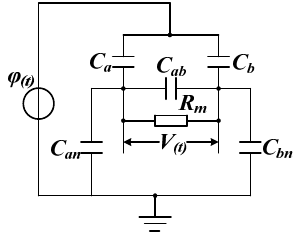
Figure 8. Equivalent circuit of voltage sensor.